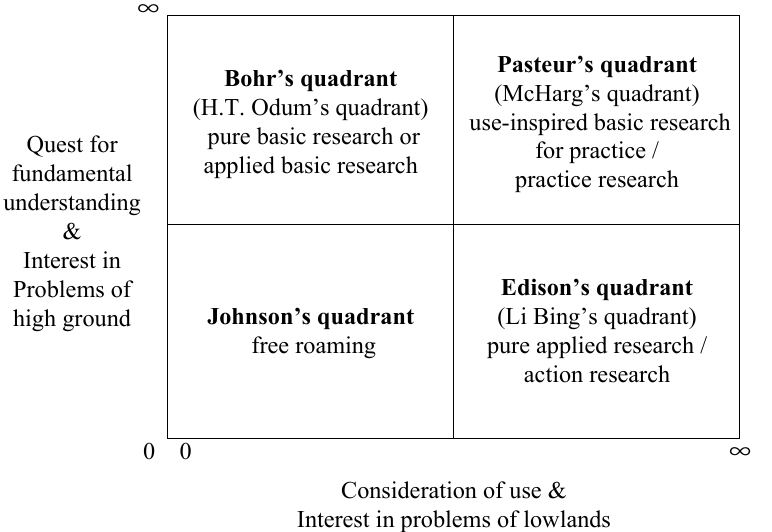
Figure 12. Data types used in the selected articles. The Schön–Stokes model of research in socio- ecological systems. (Designating the four quadrants with the names of the American systems ecologist H.T. Odum, the American ecological planner Ian McHarg, American historian Paul Johnson, and the Chinese ecological engineer Li Bing, respectively)